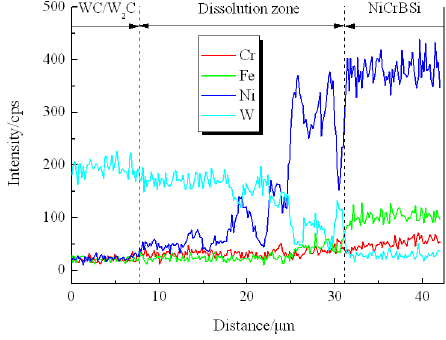
Figure 5. EDS line scan from unmodified CTC P to NiCrBSi.